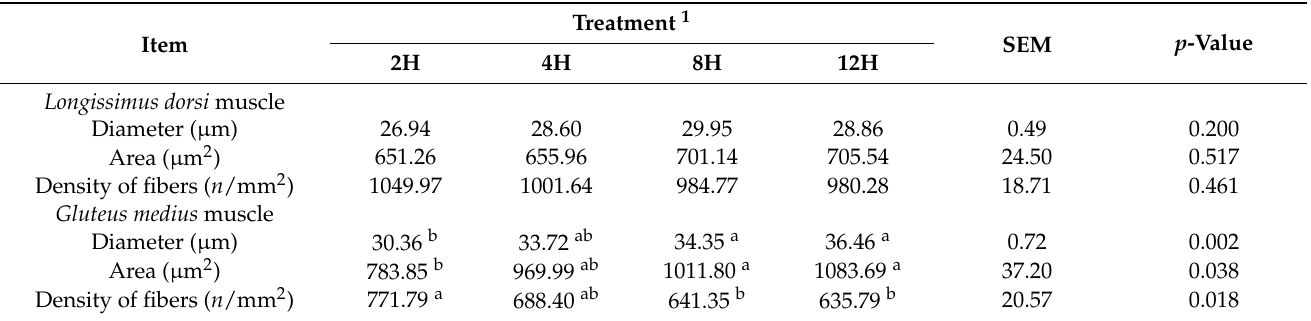
Table 3. Morphological characteristics of longissimus dorsi and gluteus medius muscles of lambs following different grazing treatments.